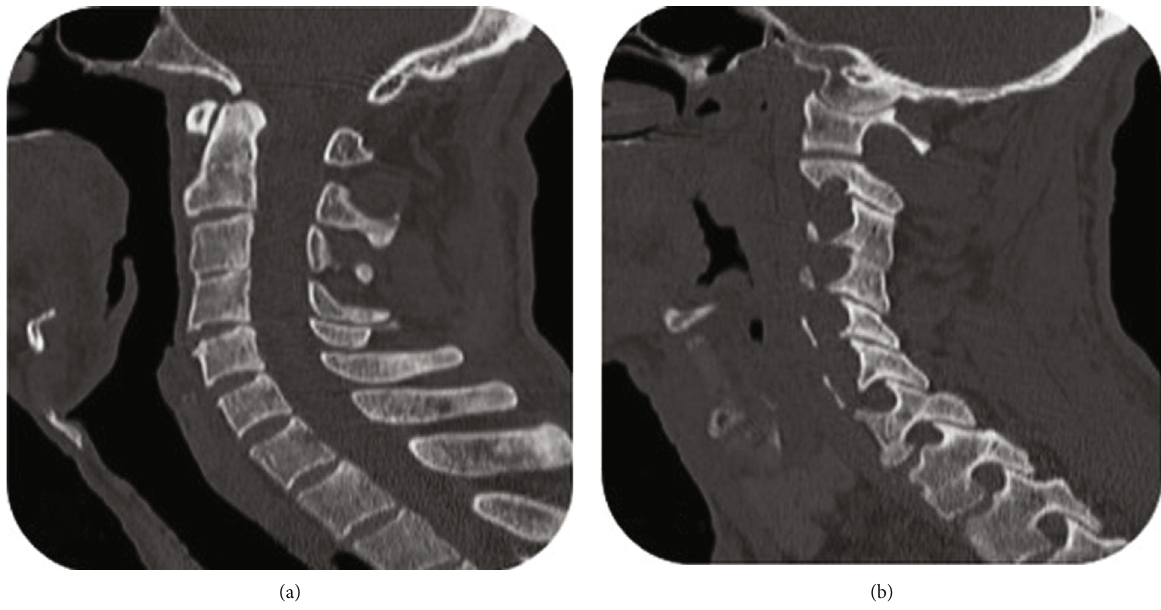
Figure 5: Sagittal spiral CT scan of cervical spine, showing C3-C4 partial fusion (a) and expanded intervertebral foramina mostly at C1-C2 level (b).